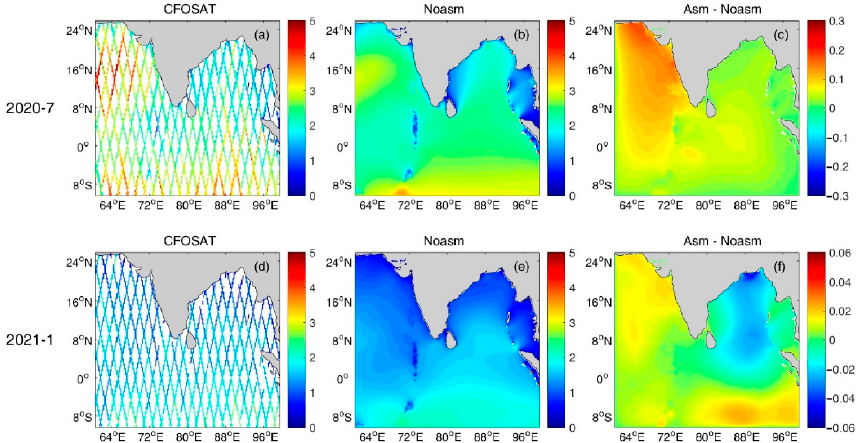
Figure 5. Spatial distribution of SWH (in meters) in July 2020 and January 2021. ( a ) SWH of CFOSAT in July 2020; ( b ) SWH of MASNUM wave model without assimilation in July 2020; ( c ) Difference of SWH with and without assimilation of Jason-3 wave data in July 2020; ( d ) SWH of CFOSAT